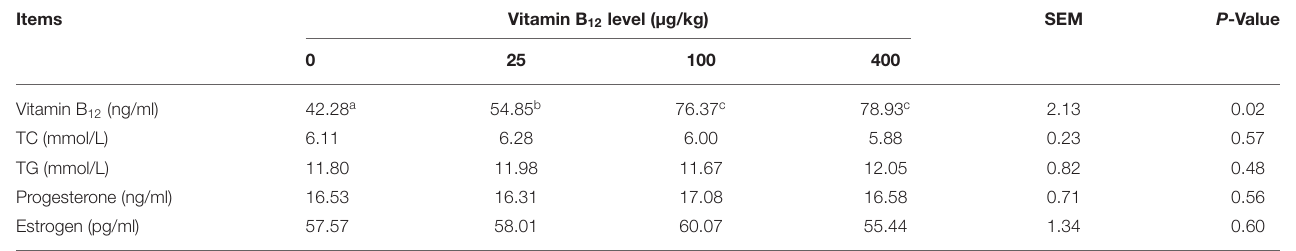
Table 3 lists the effect of dietary vitamin B 12 on egg